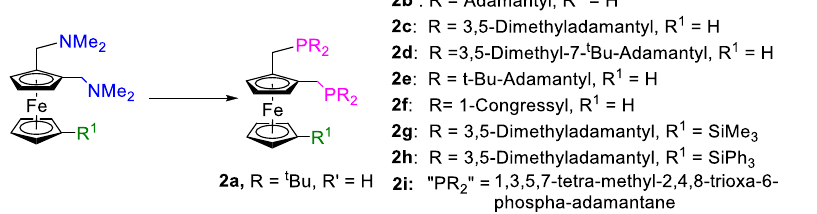
Figure 17. Examples of the bulky ferrocenyldiphosphines obtained from precursor 5 and the sec- ondary phosphanes, HPR 2 .